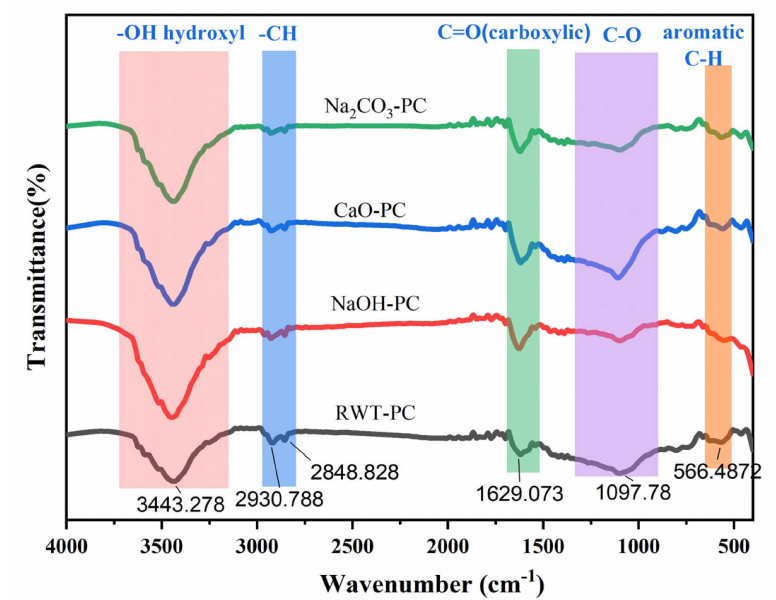
Figure 2. Surface chemical properties of pyrolytic char (PC) derived from waste